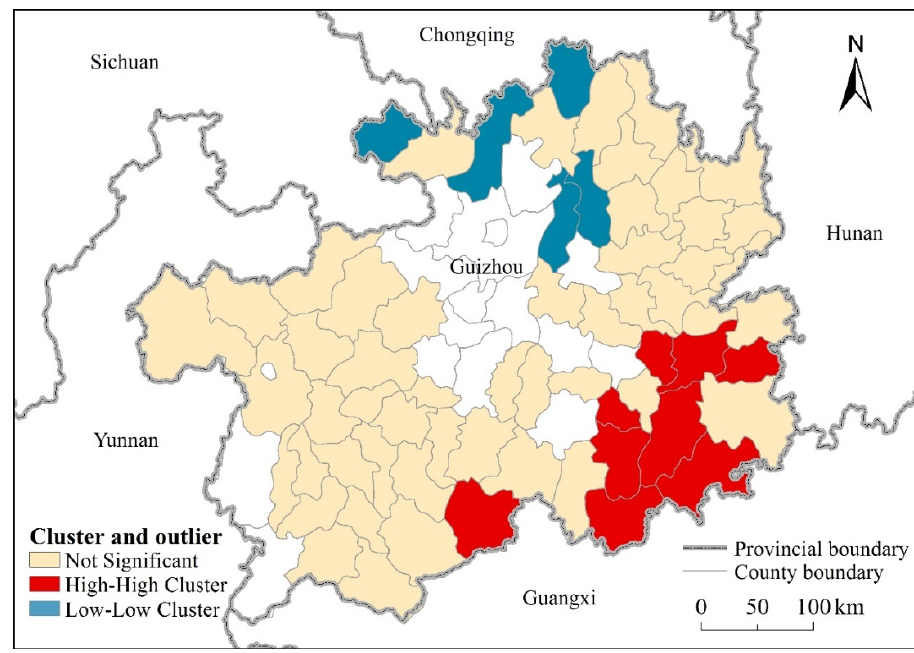
Figure 6. Local autocorrelation of county-level poverty incidence in Guizhou Province.